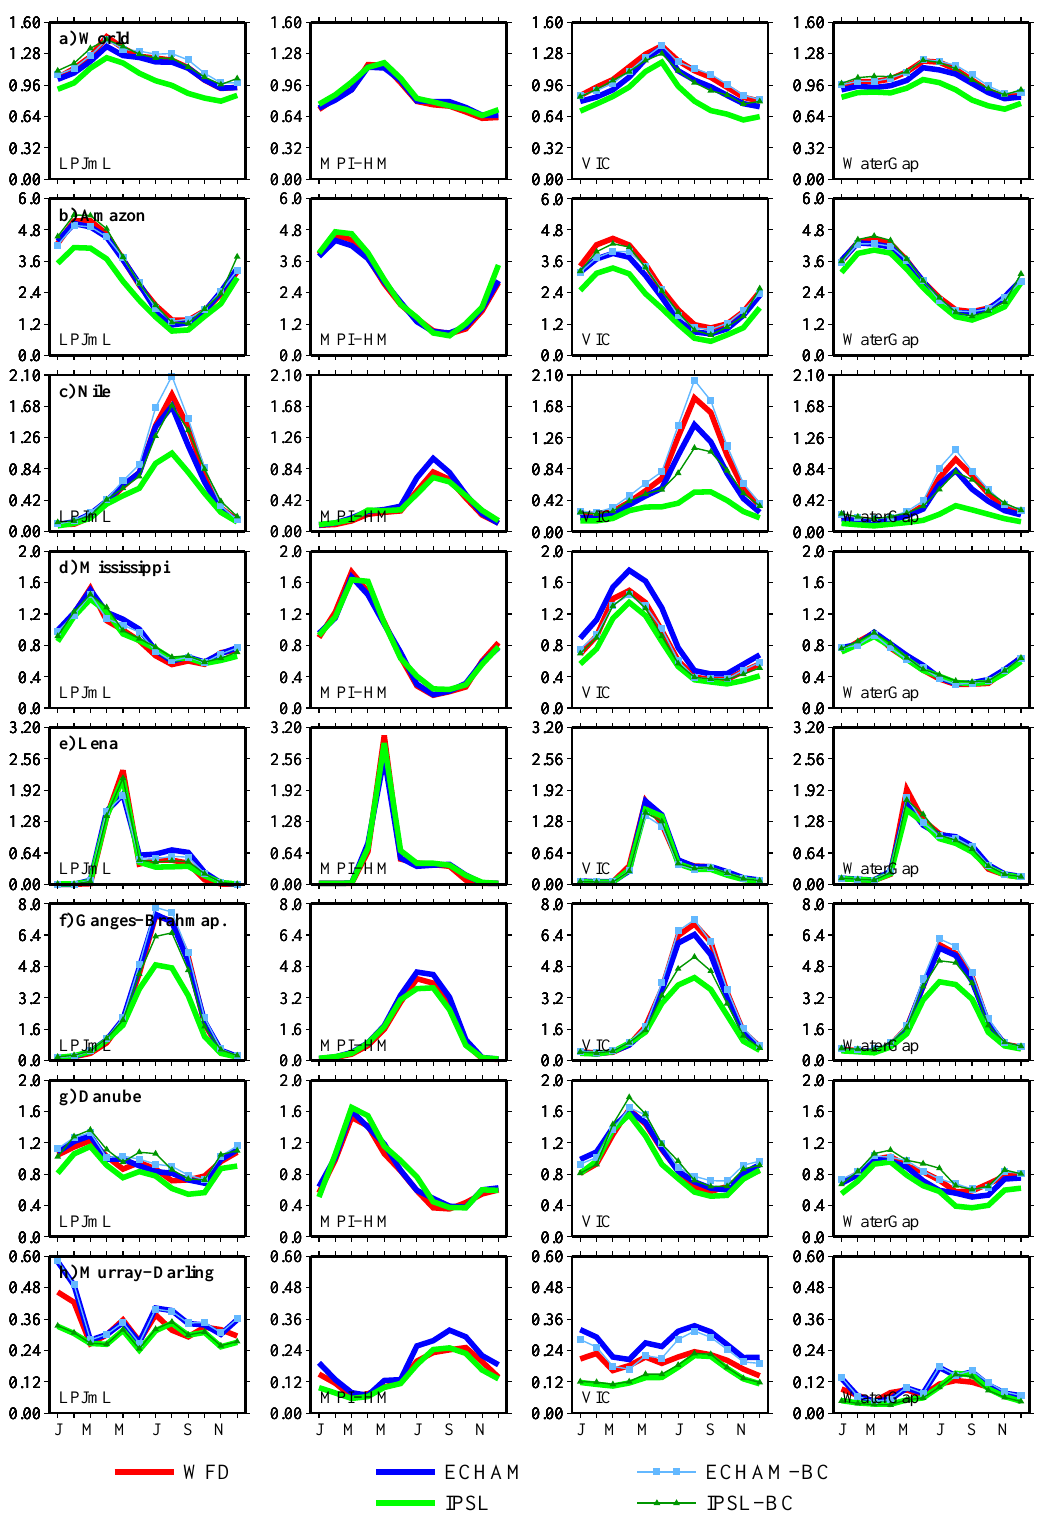
Figure 6: Global terrestrial mean monthly simulated runoff (mm day -1 ), and results for the 2 Fig. 6. Global terrestrial mean monthly simulated runoff (mmday − 1 ) , and results for the study basins (control period; 1971–2000). Original study basins (control period; 1971-2000). Original and bias corrected results when applicable. 3 and bias corrected results when